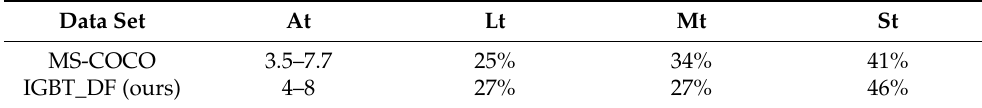
Table 1. Object distribution of the IGBT